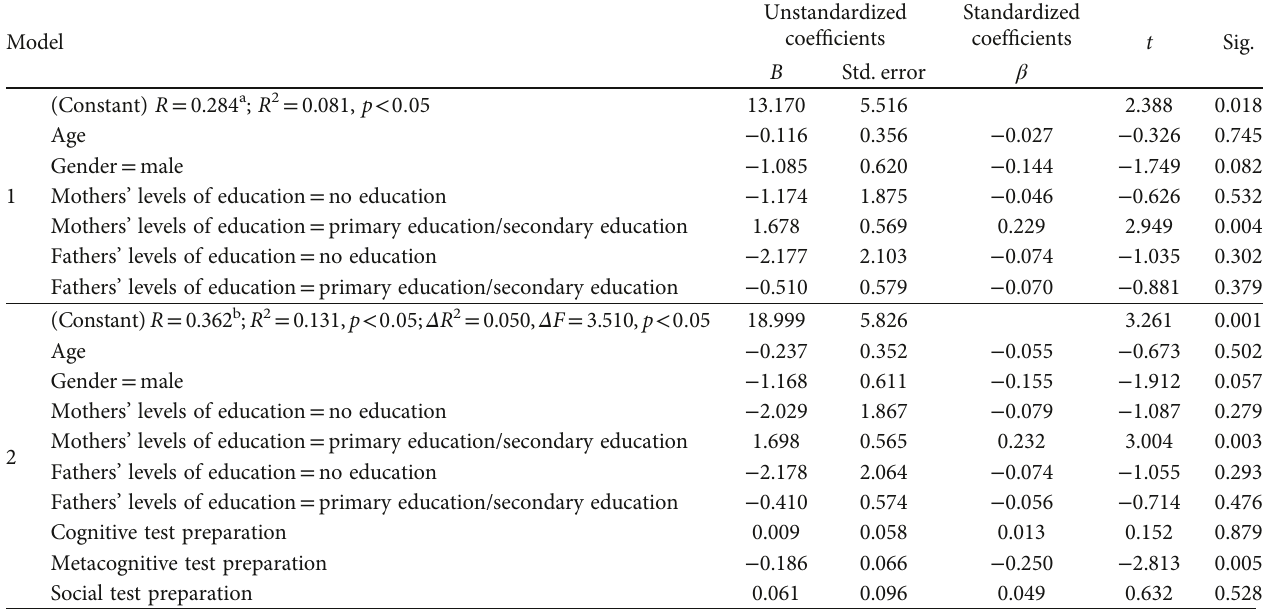
T ABLE 5: Hierarchical regression analysis for test preparation strategies and physiological test anxiety.